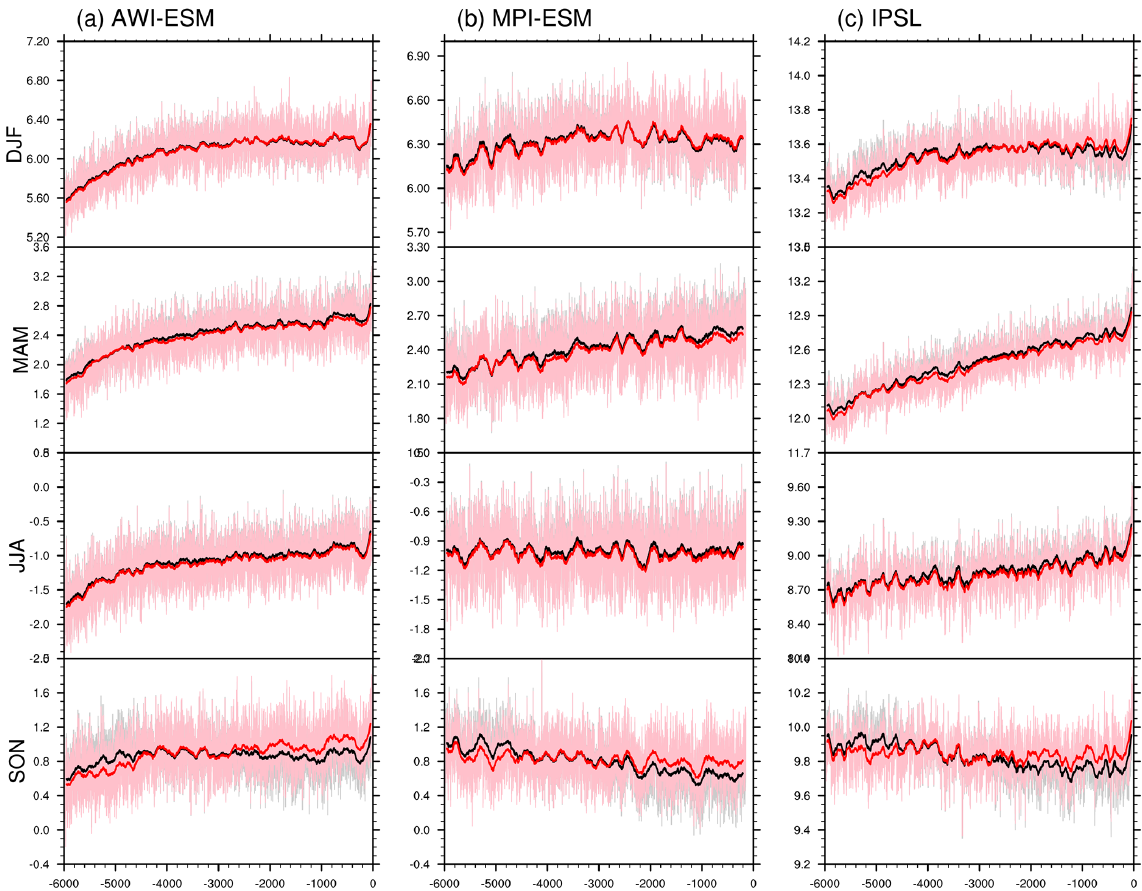
Figure 15. Time series of surface air temperature in classical and angular means averaged over Southern Hemisphere oceans, weighted by month length, for (a) AWI-ESM, (b) MPI-ESM, and (c) IPSL-CM. Grey and pink lines stand for the original classical and angular means respectively. Smoothed curves with a running window of 100 model years are shown in black (for classical means) and red (for angular means). Units: ◦